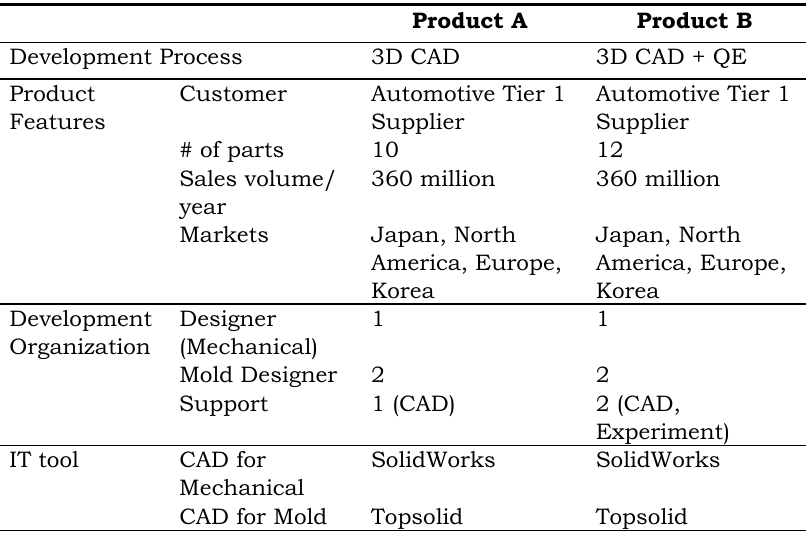
Table 2. Profiles of Product A and Product